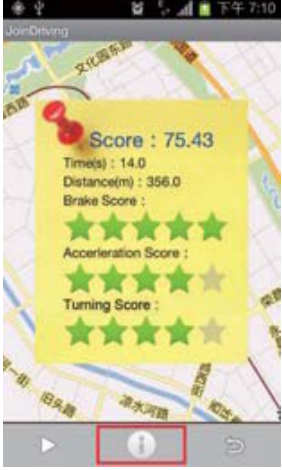
Figure 2. JoinDriving : Riding comfort related scores for an example driver